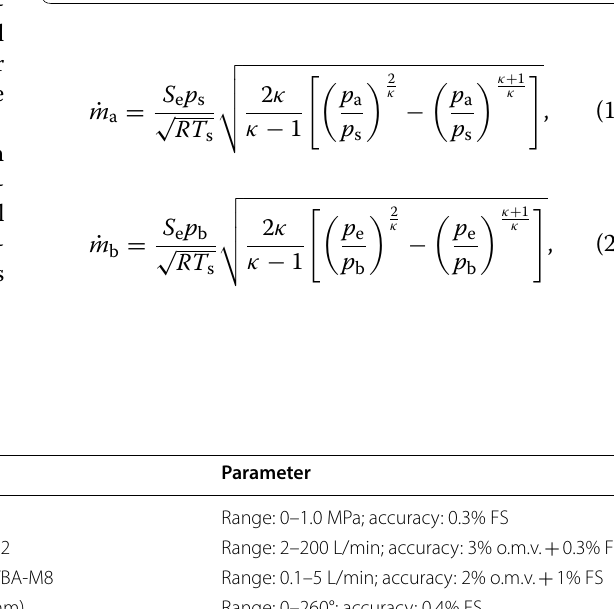
Figure 3 Circuit connection of the experimental